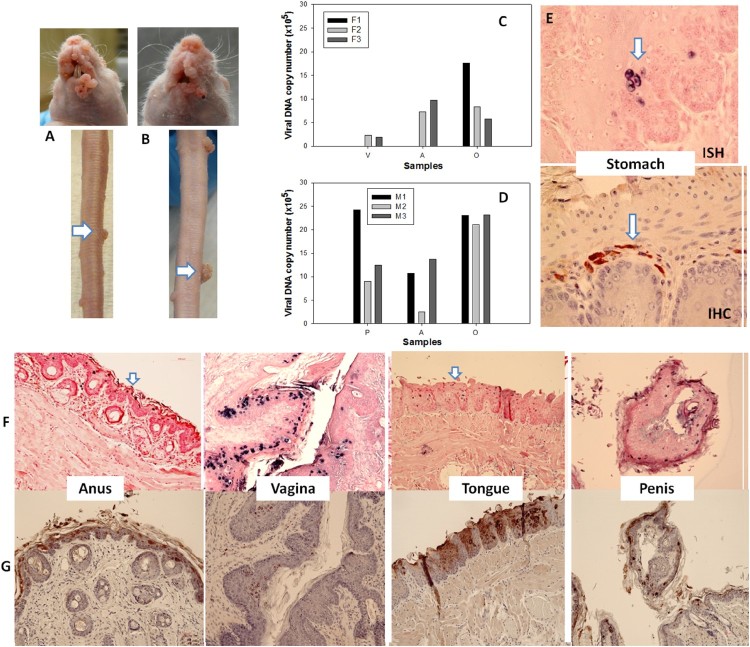
Blood of MmuPV1 infected mice with skin tumours was infectious at seven
months post initial IV injection. Each naïve littermate transfused by IV injection
of 0.2 mL of blood (<1 × 104 viral copies) from two infected mice
sacrificed seven months after initial IV MmuPV1 infection was examined weekly for
tumour growth at the pre-wounded skin area. (A, B) Representative tumour growth
(arrows) at the muzzle and the tail of naïve Hsd: Nu female (A) and male (B) mice at
week sixteen post blood transfusion. Viral DNA was detected at the vaginal (V), anal
(A) and oral (O) sites in three females (C, F1-F3) and the penile (P), anal (A) and
oral (O) sites in three male (D, M1-M3) mice by qPCR. Mucosal sites of these mice
(the vagina, anus, tongue, and penile) were positive for viral DNA by in situ
hybridization (F, arrows, 20×, in blue). These tissues were positive for viral E4
protein (G, 20×, in red). One of the females was positive for viral DNA (ISH arrows,
60×, in blue) and viral capsid protein L1 (IHC, arrows, 60×, in red) in the stomach
tissues (E).